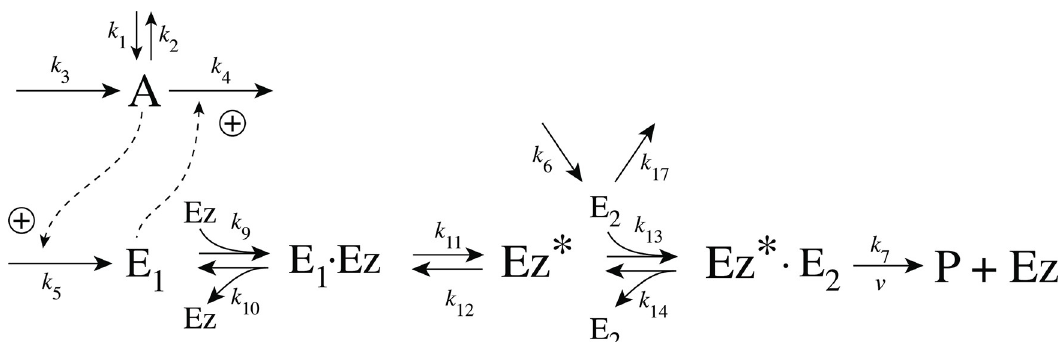
Fig 44. Scheme of the m5 controller when E 1 and E 2 are removed by a ping-pong mechanism with E 1 binding first to the free enzyme Ez .